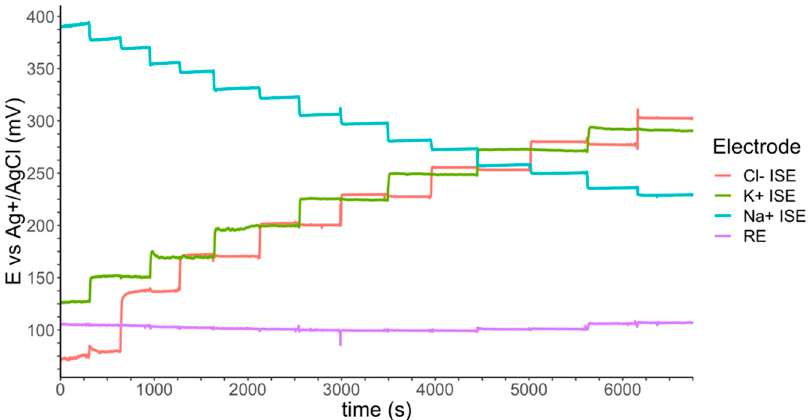
Figure 2. Potential response of ISEs and RE to increasing concentrations of NaCl and KCl. Activities determined by Debye-Hückel model, ranging from log( 𝑎 (cid:3036) ) = − 4.5 to − 0.5 ( 𝑖 (cid:3404) 𝑁𝑎 (cid:2878) , 𝐾 (cid:2878) , 𝐶𝑙 (cid:2879)